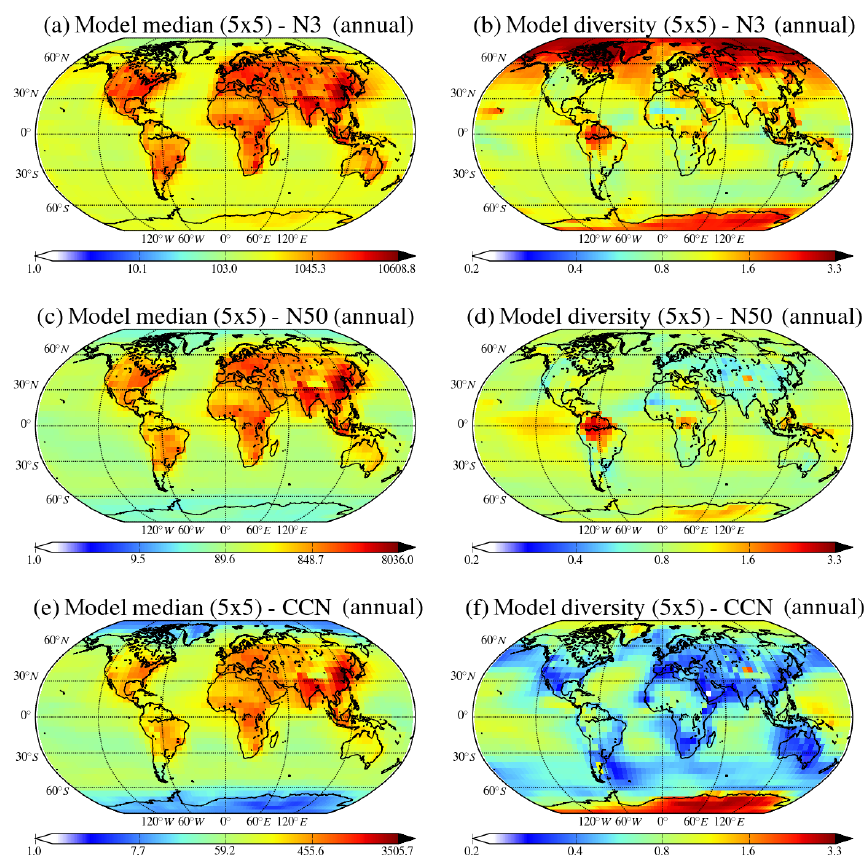
Figure 10. Global distributions of the annual multi-model median concentrations of N 3 , N 50 and CCN 0 . 2 (cm − 3 ) for the year 2011 ( a, c, e , respectively) and the corresponding diversities ( b, d, f , respectively; calculated as the ratio of standard deviation to the mean of the models).